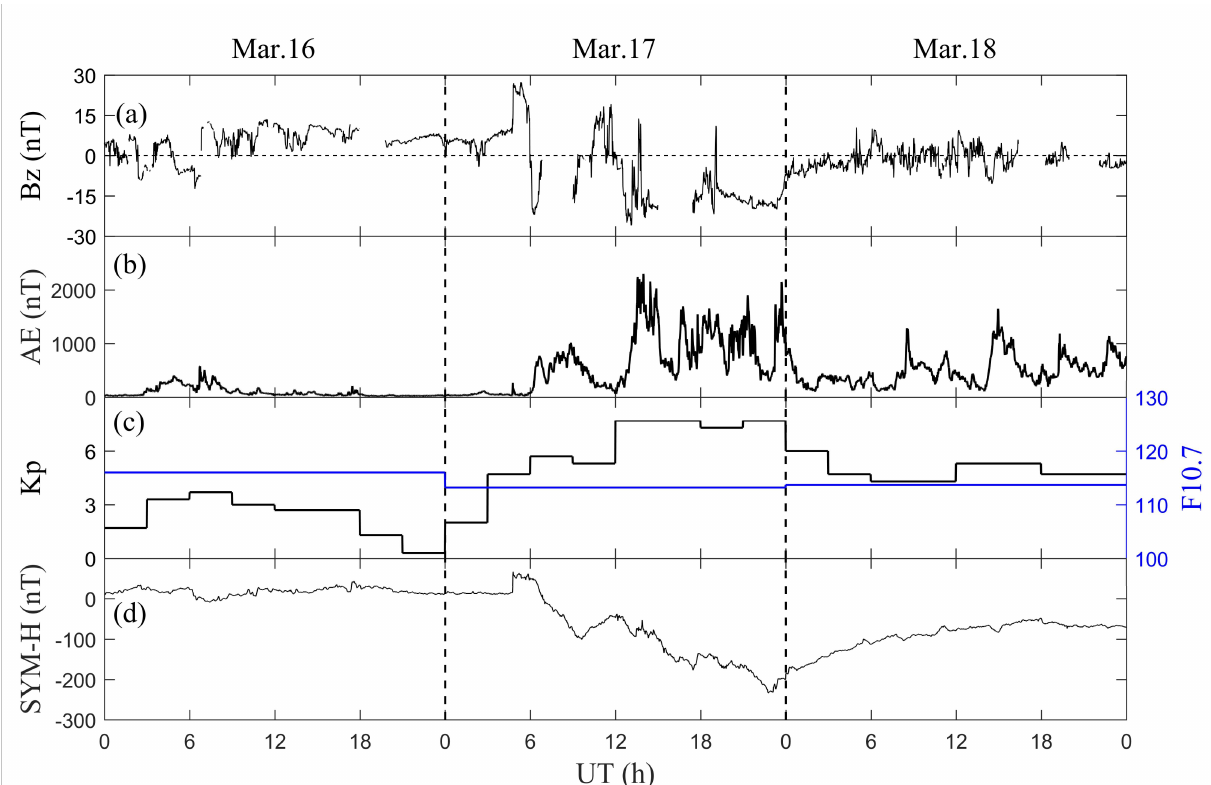
Figure 6. Time series of ( a ) IMF Bz, ( b ) AE index, ( c ) Kp index (dark line) and F10.7 (blue line), and ( d ) SYM-H index during the period of 16 − 18 March